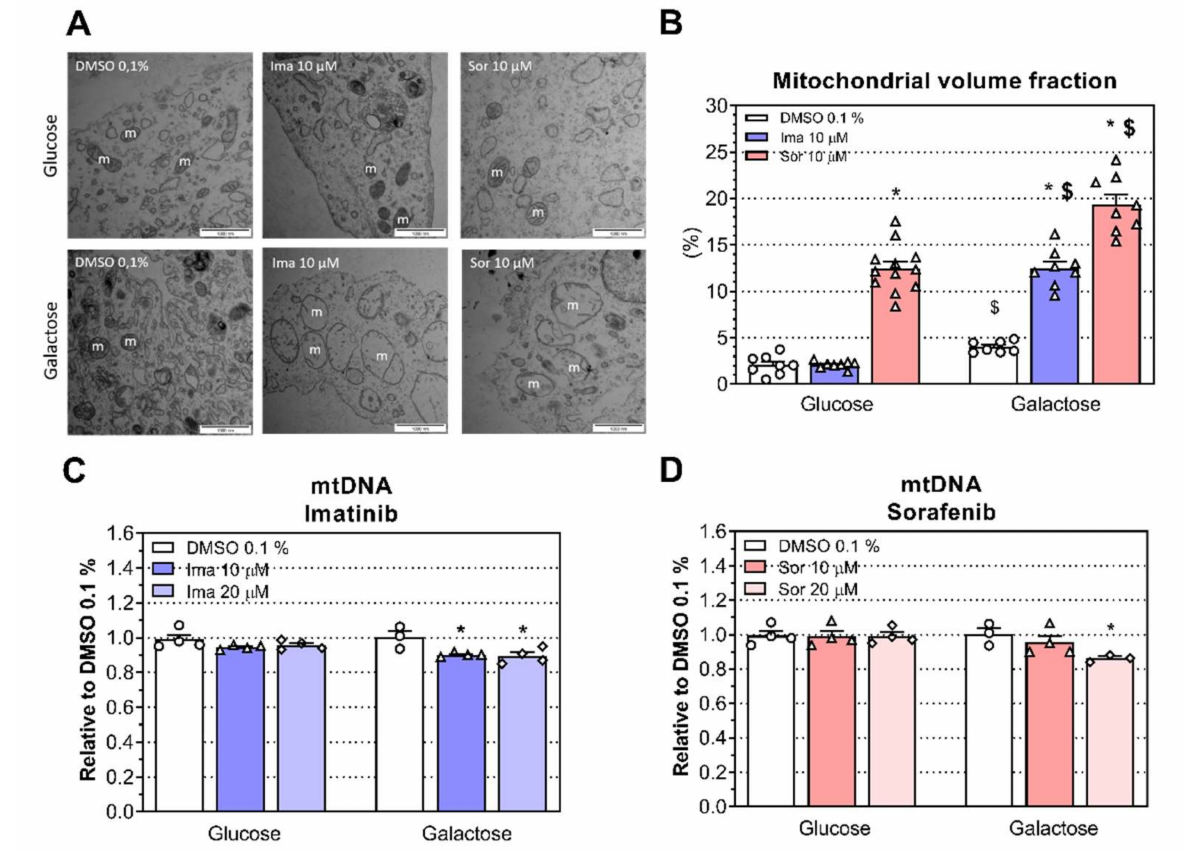
Figure 5. Mitochondrial morphology and mtDNA content of H9c2 cells exposed to imatinib (Ima) and sorafenib (Sor) for 24 h under glucose and galactose media. ( A ) Transmission electron microscopy images of H9c2 cells exposed to 10 µ M imatinib and 10 µ M sorafenib under glucose and galactose conditions (m: mitochondrion; scale bar = 1000 nm). ( B ) Mitochondrial volume fraction in H9c2 cells. ( C ) Mitochondrial DNA content in H9c2 cells exposed to imatinib at 10 µ M and 20 µ M for 24 h under glucose and galactose media. ( D ) Mitochondrial DNA content in H9c2 cells exposed to sorafenib at 10 µ M and 20 µ M for 24 h under glucose and galactose media. Data represent the mean ± SEM of at least three independent experiments. * P < 0.05 treatment groups versus 0.1% DMSO control; $ P < 0.05 galactose versus glucose of the same treatment